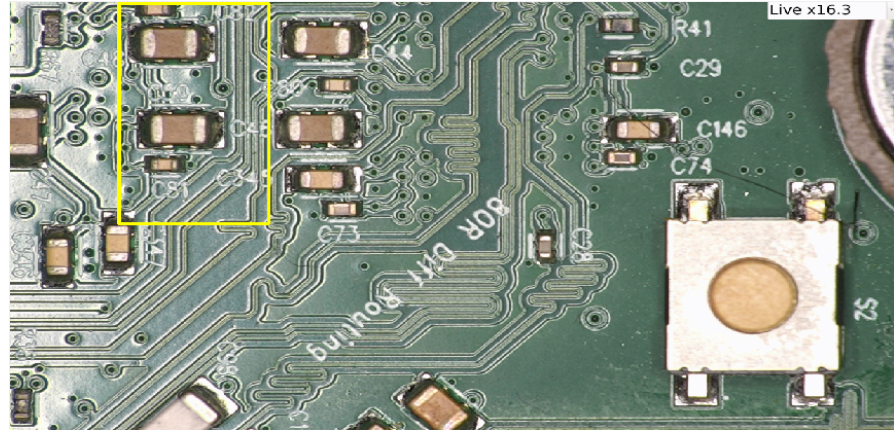
Figure 6. The yellow area is matched to the overall image in experiment 2.